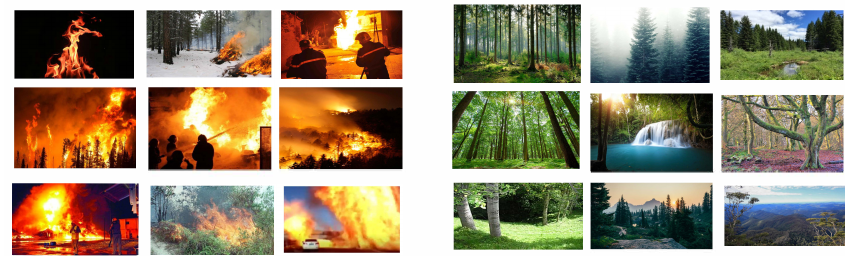
Figure 2. Sample fire and non-fire images in the training dataset